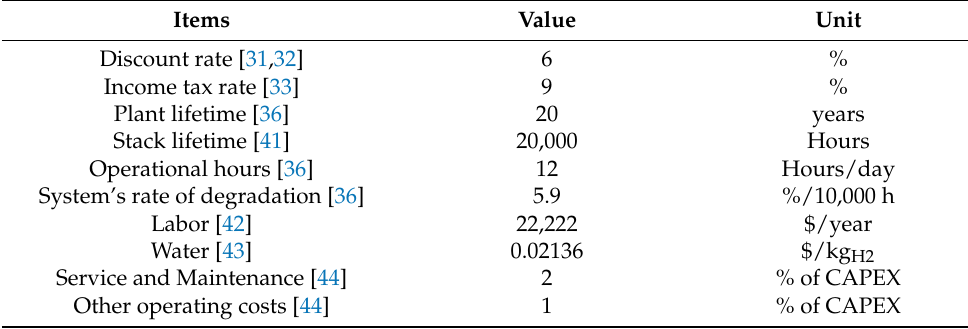
Table 5. SOEC electrolyzer plant operational costs factors and values.